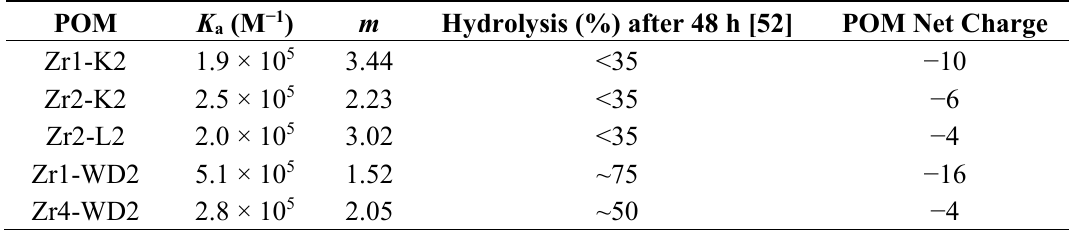
Figure 2. Emission fluorescence spectra of HSA in the absence and presence of different concentrations of Zr2-L2 ([HSA] = 10 − 5 M, pH = 7.4). From top to bottom, the concentration of Zr2-L2 increased stepwise from 0 to 10 − 5 M with increments of 10 − 6 M. In the inset, the plot of the Tachiya equation is given (with R 2 = 0.99). From the plot, K a and m were calculated to be 2.0 × 10 5 M − 1 and 3.02, respectively. Table 1. Calculated values of the quenching constants, their corresponding number of bound molecules, the percentage of hydrolyzed human serum albumin (has) after 48 h incubation at pH 7.4 and 60 °C [52] and their polyoxometalates (POM) net charge for different POM:HSA